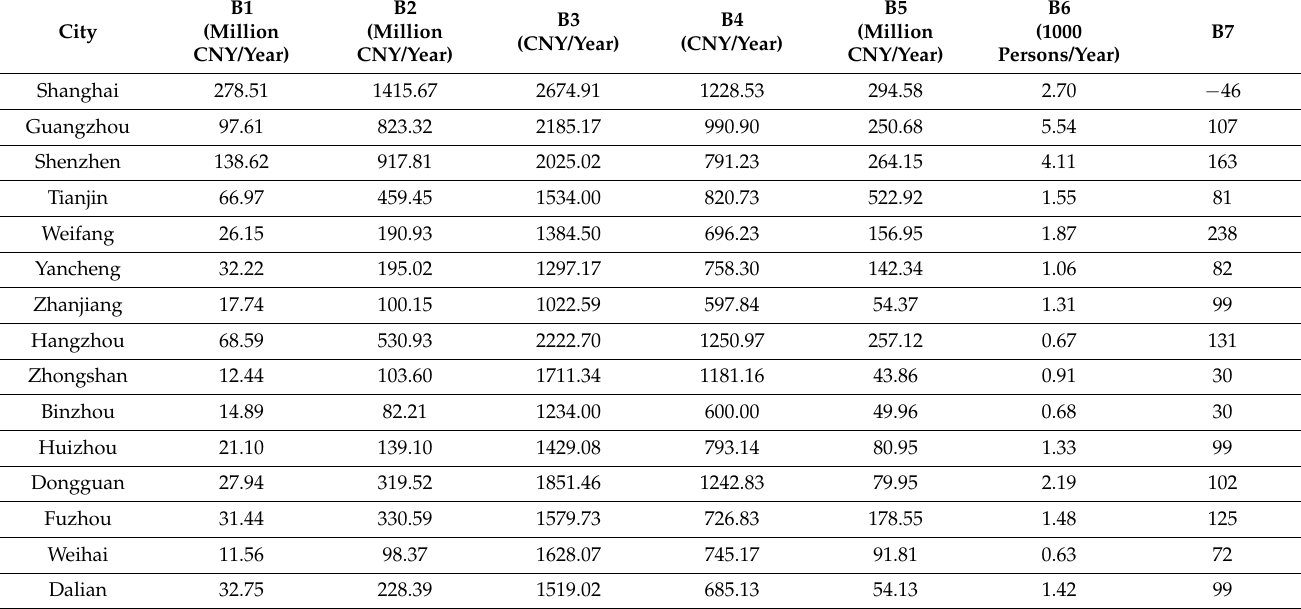
Table A3. The annual mean change rate of adaptability index in 15 coastal cities from 1990 to 2020.